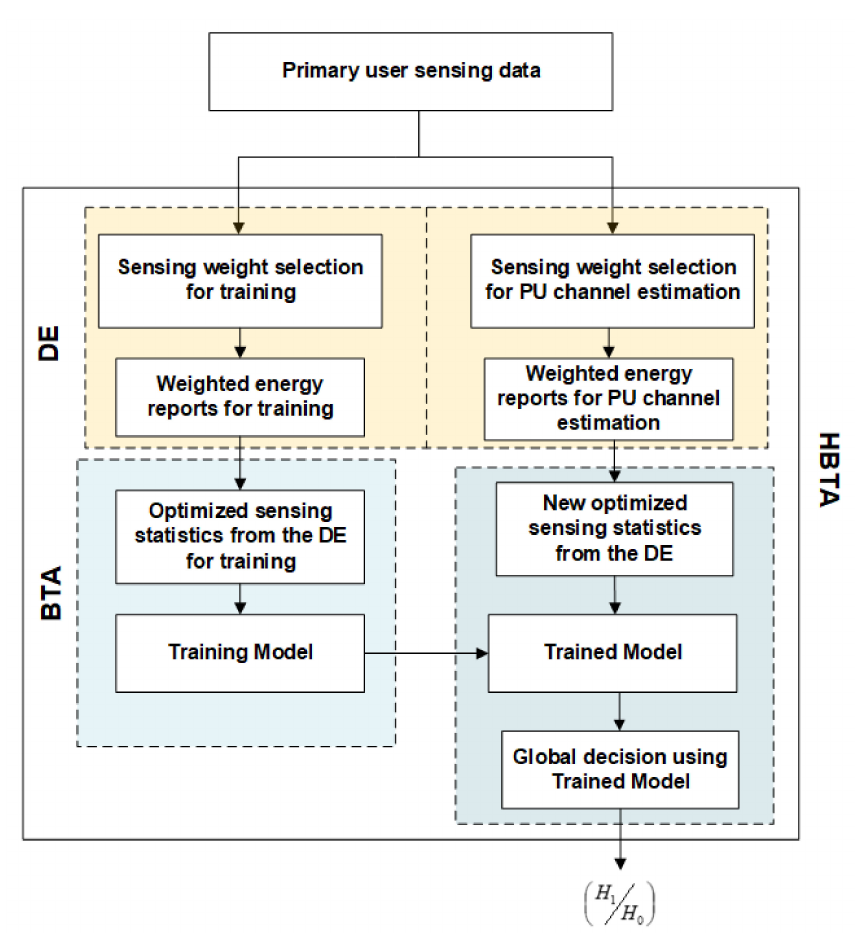
Figure 2. Abstract functional block diagram of the hybrid boosted tree algorithm